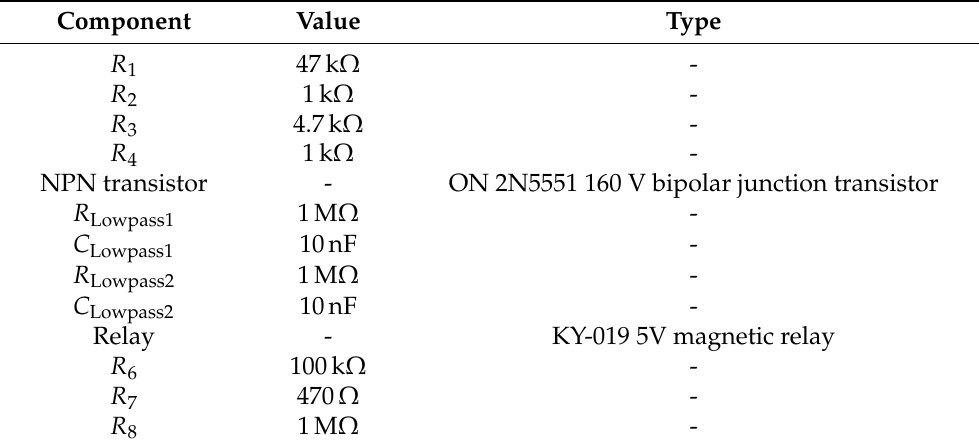
Table A1. Values and types of used electrical